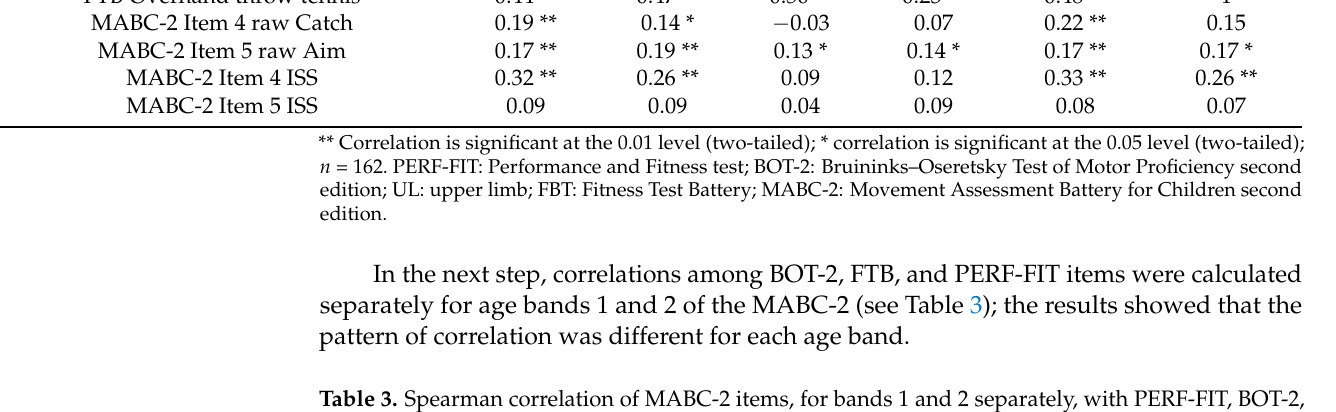
Table 3. Spearman correlation of MABC-2 items, for bands 1 and 2 separately, with PERF-FIT, BOT-2, and FTB.